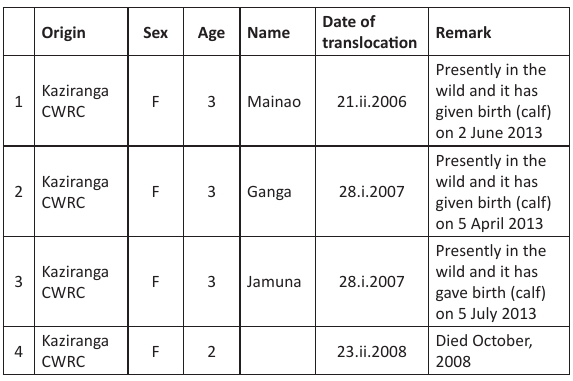
Table I. Details of Rescued rhino’s translocation to Manas National Park (period, 2006–2008)